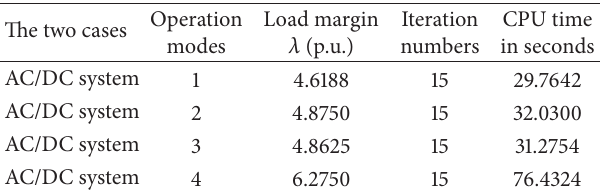
Figure 8, and the VSC 1 and VSC 2 are connected to AC line of bus 75 and bus 118,